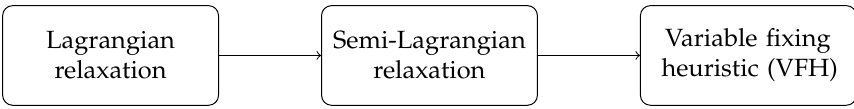
Figure 2. Scheme of steps in the ADA